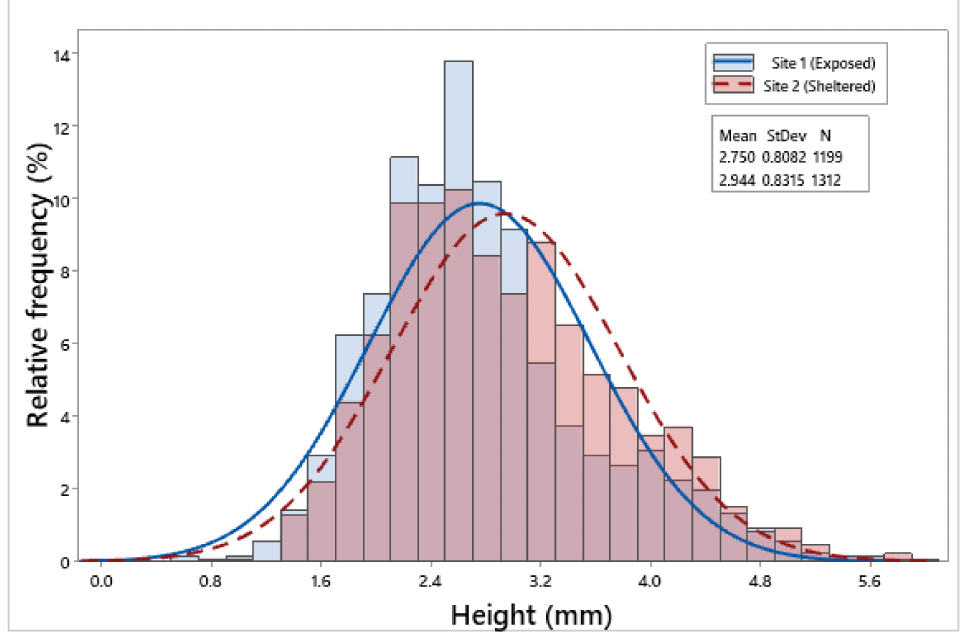
Figure 5. Total shell height–frequency distribution of C. stellatus populations with overlaid fitted normal distribution at both sampling